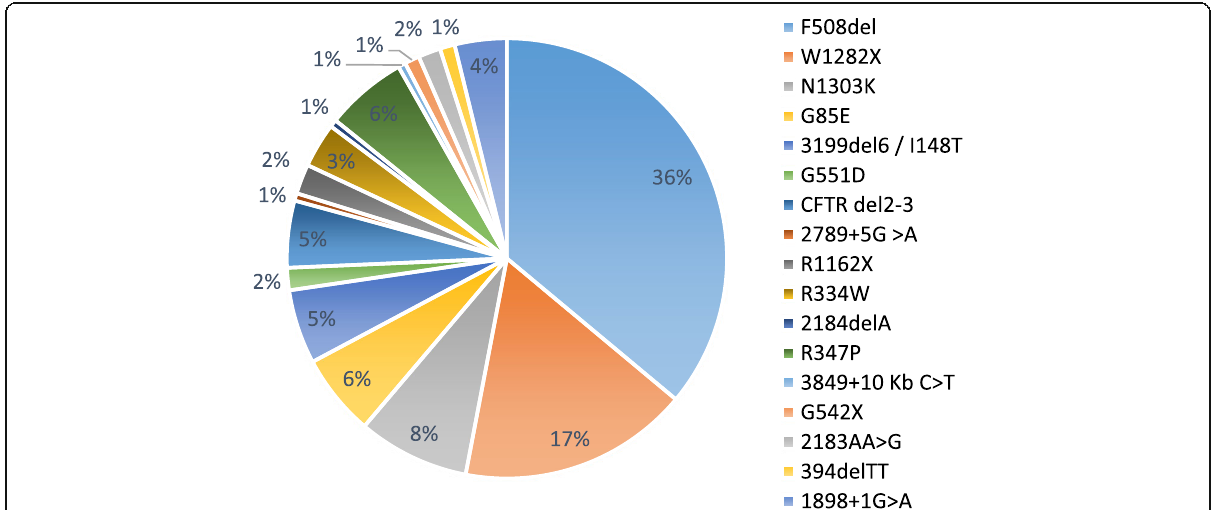
Fig. 2 The incidence of CFTR pathogenic variants detected in the studied